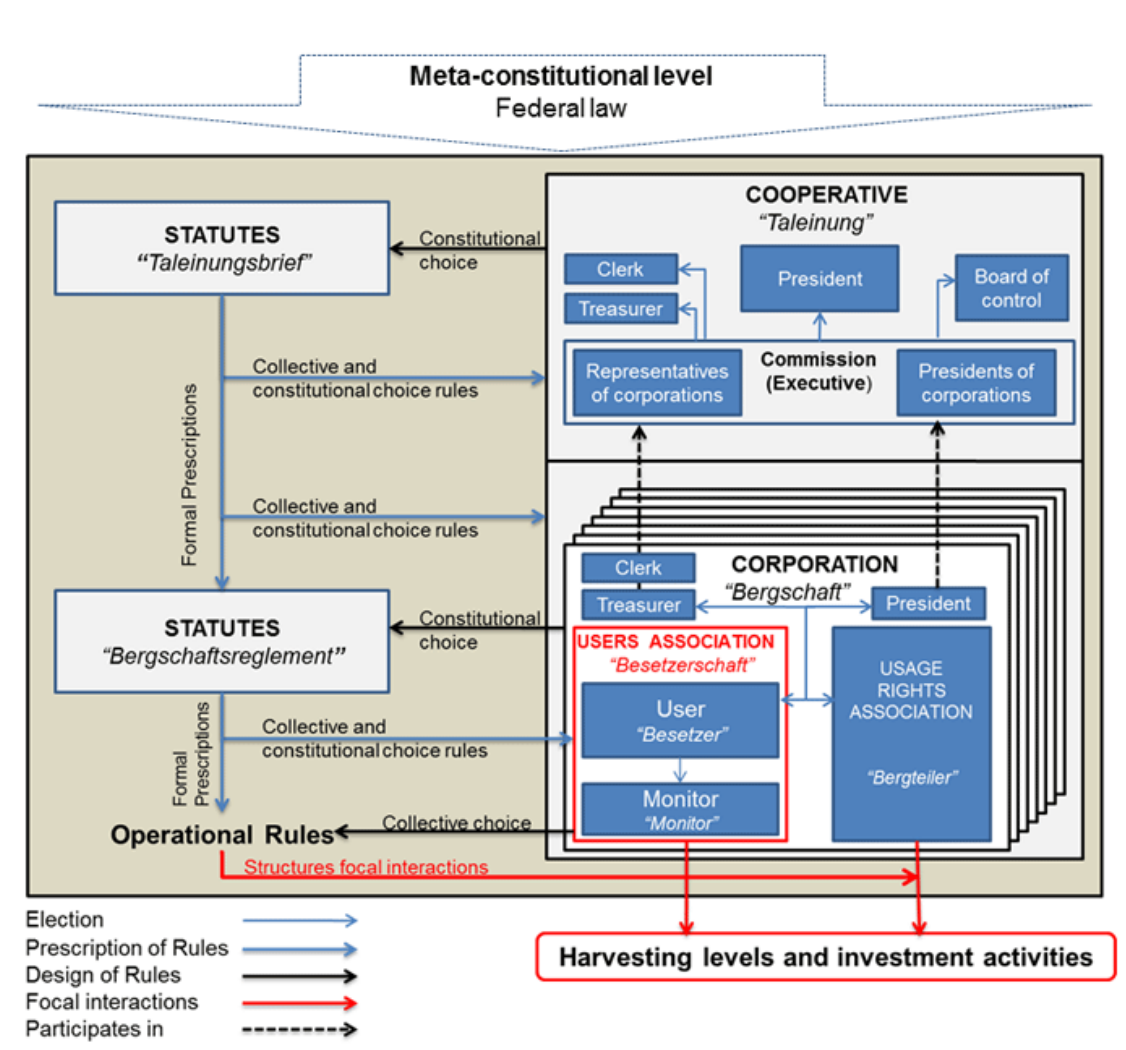
Fig. 3 .The structure of the local governance system in